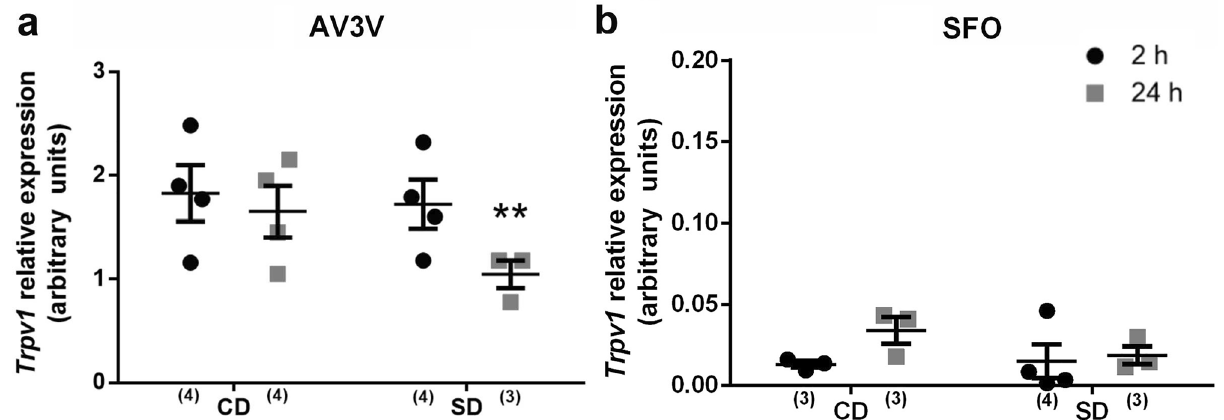
Figure 7. Brain Trpv1 mRNA expression after sodium depletion. Relative mRNA levels of transient receptor potential vanilloid type 1 ( Trpv1 ) in AV3V ( a ) an SFO ( b ) at two and 24 h after sodium depletion. Values are mean ± SE (number of cases indicated by the individual points in each case). ** p < 0.05 significant difference between SD 24 h versus other groups. SD: Sodium-depleted group. CD: Control group. AV3V: Anteroventral third